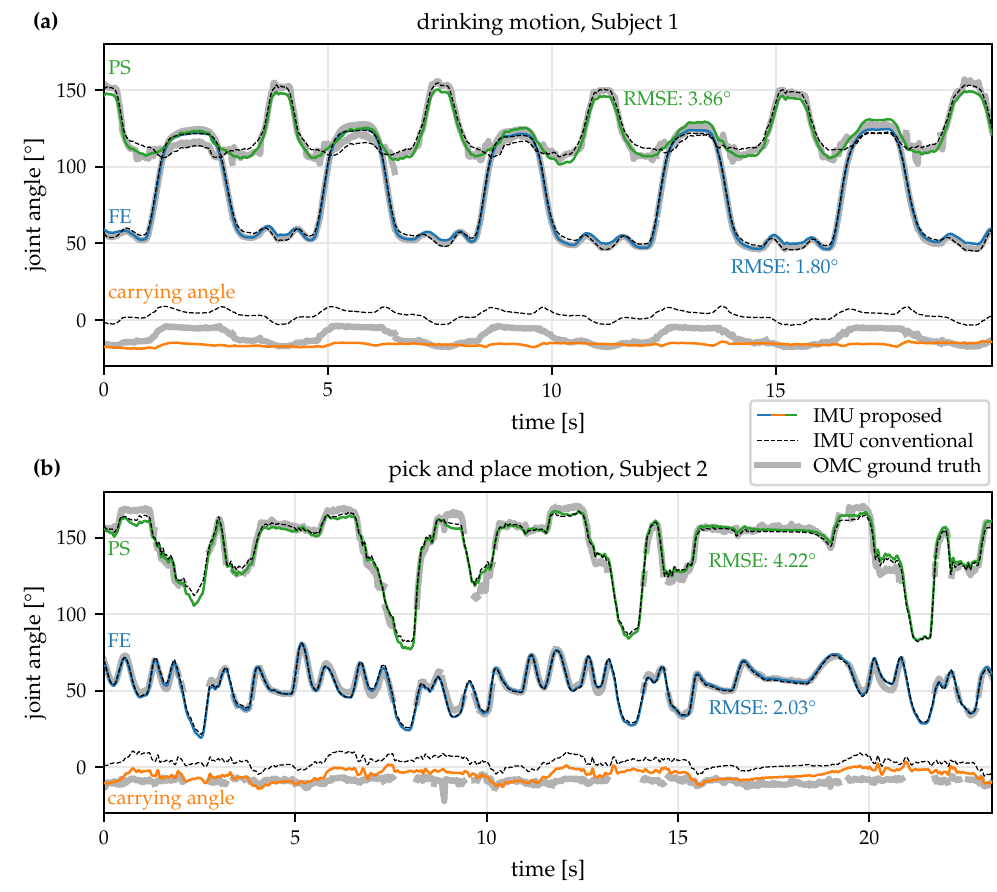
Figure 10. Joint angle trajectories for an exemplary ( a ) drinking and ( b ) pick-and-place trial obtained with the proposed IMU-based method (and the rotation-based constraint), the conventional 9D IMU-based approach, and the OMC ground truth. While being much less restrictive, the proposed method is able to obtain FE and PS joint angles that agree well with the angles obtained with the other two